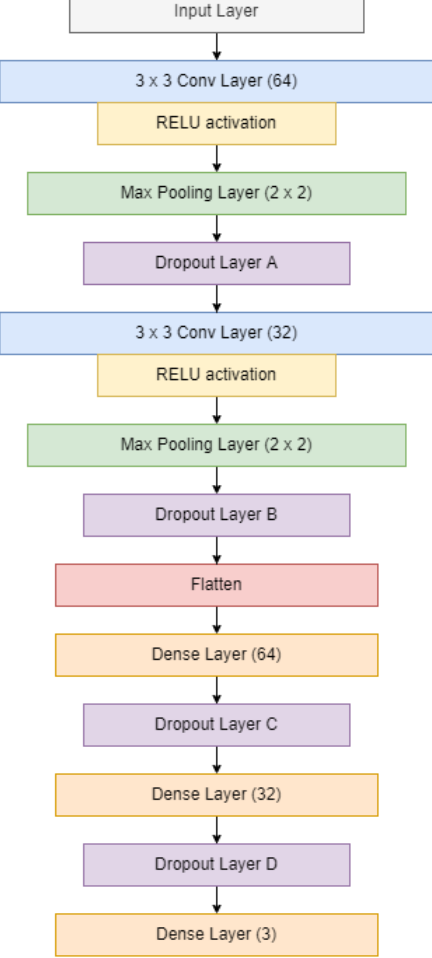
Figure 11. Architecture of the CNN